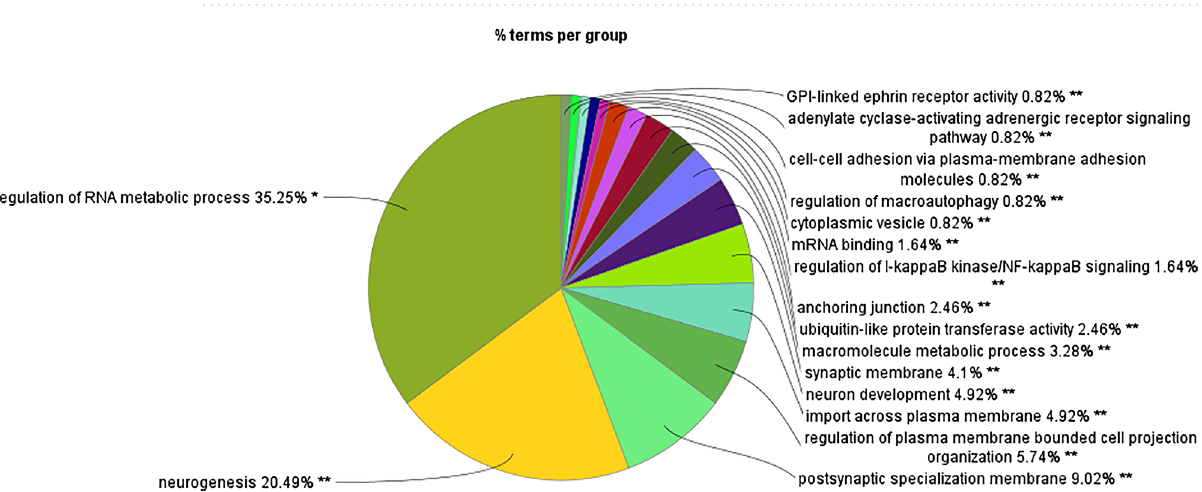
Figure 5. Results for enrichment analysis for target genes of gga-miR-1612: GO networks and Kappa score groups of GOs.